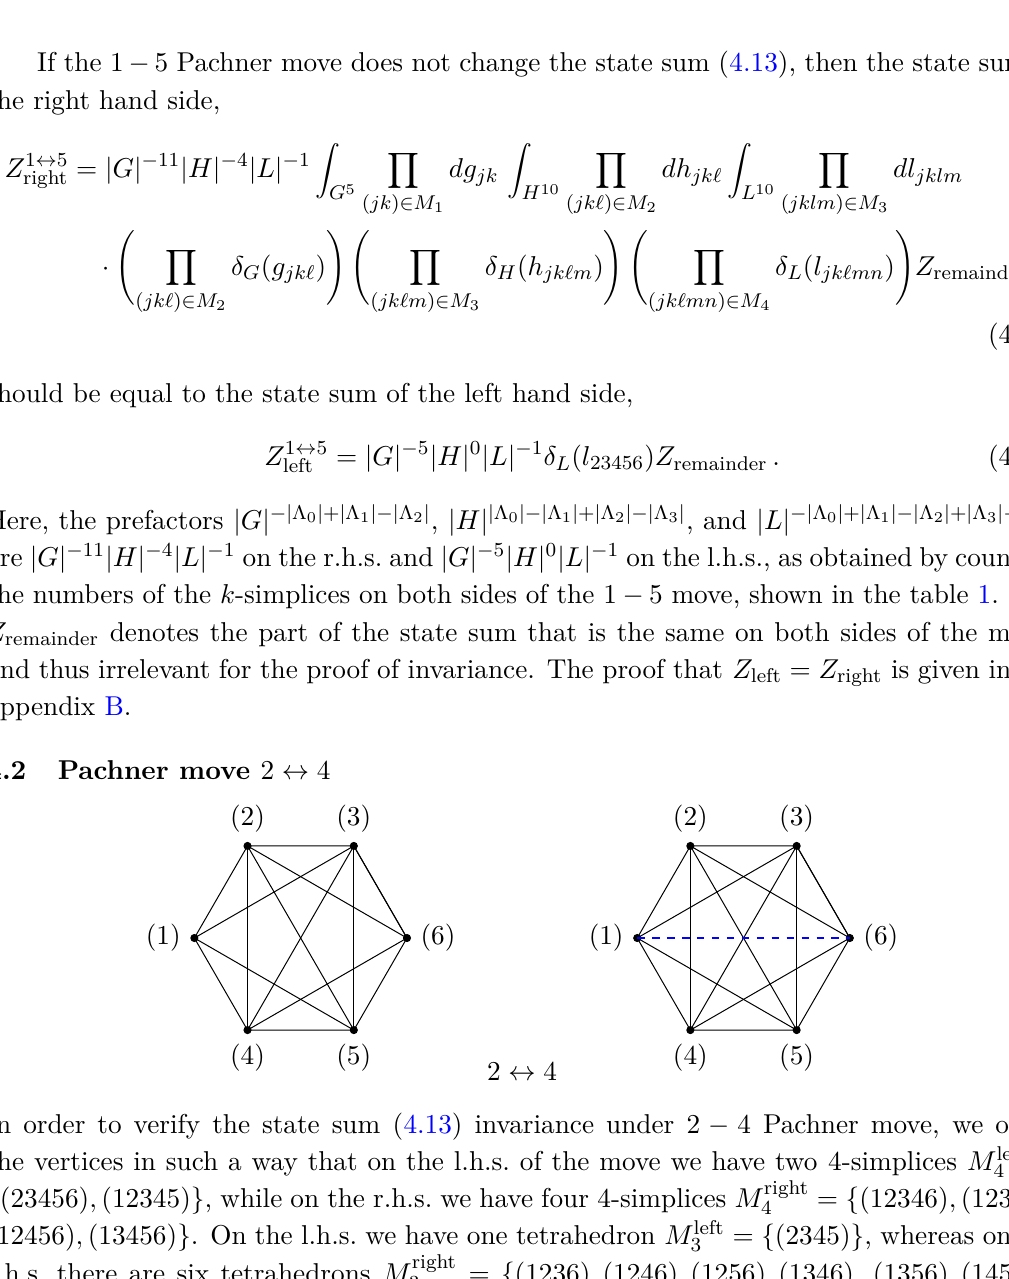
Table 1 . Number of vertices | Λ 0 | , edges | Λ 1 | , triangles | Λ 2 | , tetrahedrons | Λ 3 | , and 4-simplices | Λ 4 | on both sides of the 1 ↔ 5